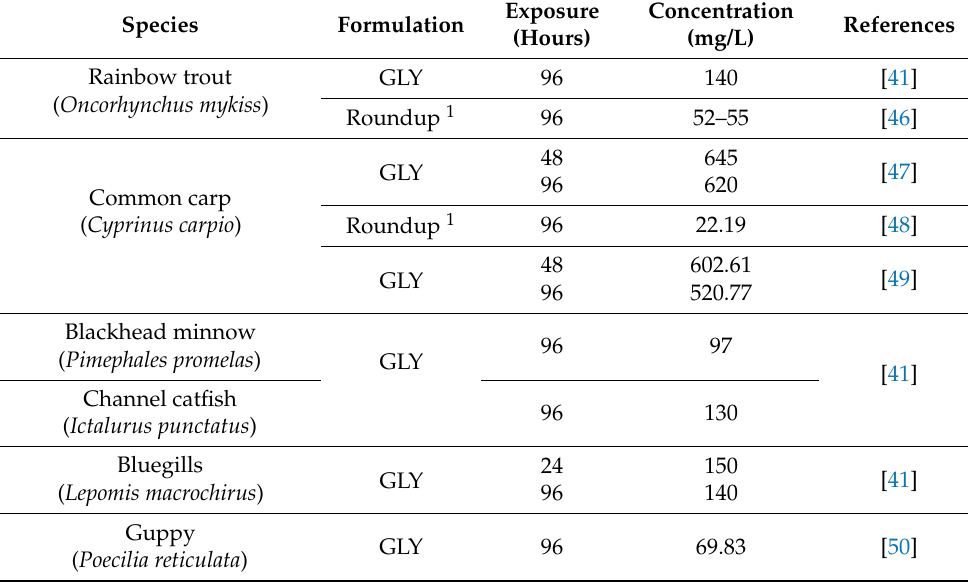
Table 1. Acute toxicity values (LC50) of glyphosate and its commercial products on